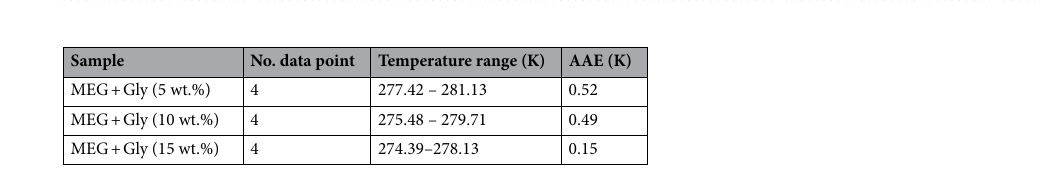
Table 2. Predicted carbon dioxide hydrate equilibrium points in the presence of different THIs.